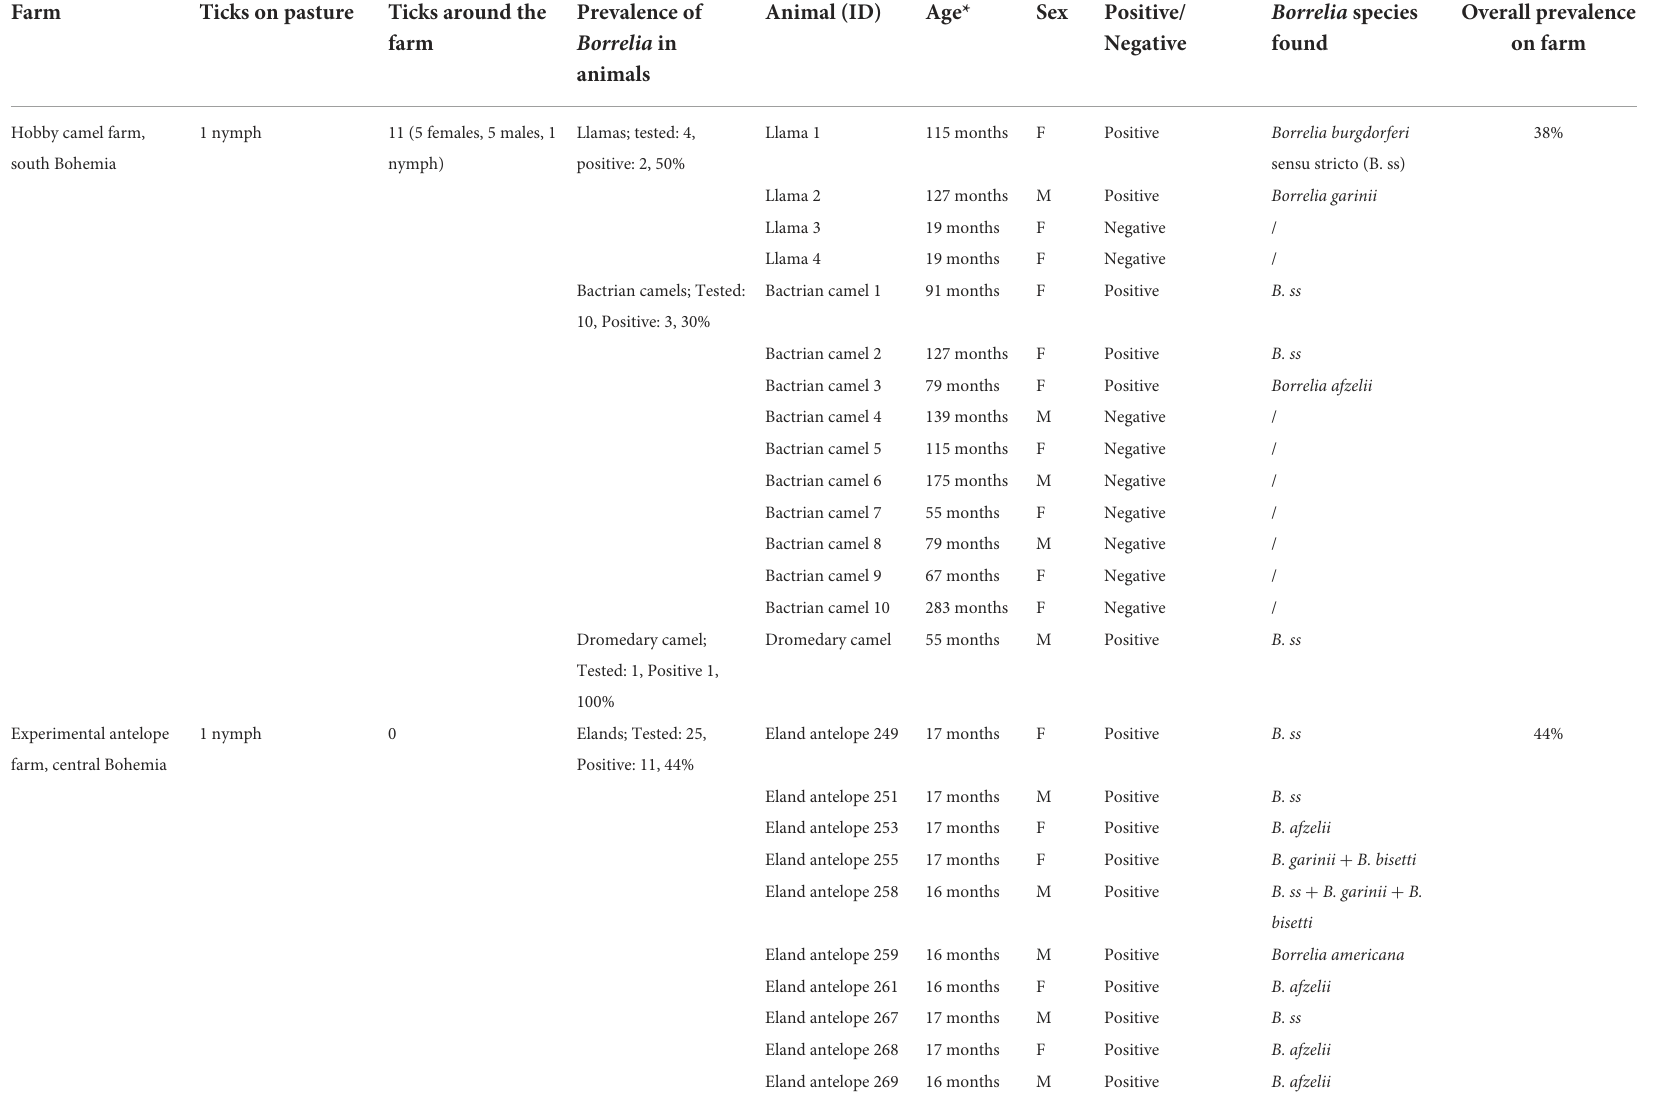
TABLE 1 The results of Borrelia testing and tick collections on selected exotic animal farms in Czechia.